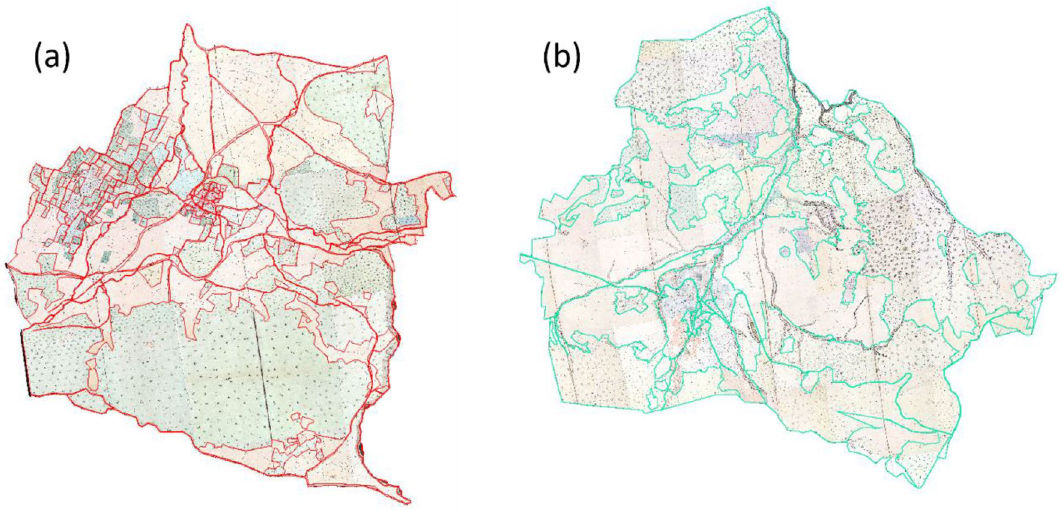
Figure 6. Vectorized cadastral maps of ( a ) Kestel and ( b ) Aksu with Red and green lines showing the vector